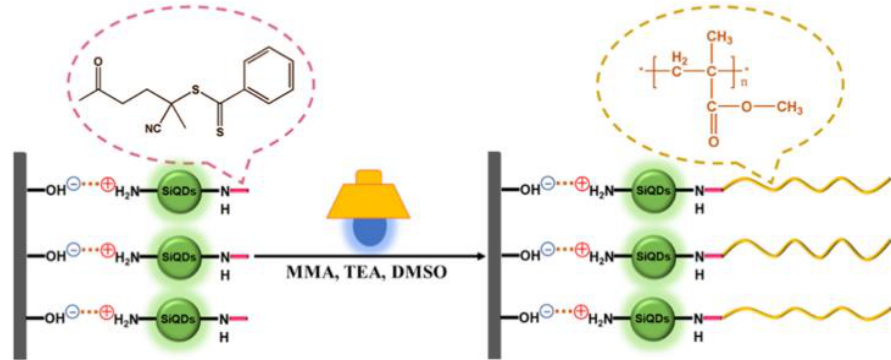
Figure 11. Reaction scheme of in Situ SiQD-Catalyzed Surface-Initiated PET-RAFT Polymerization. Reproduced with permission from ref. [80].